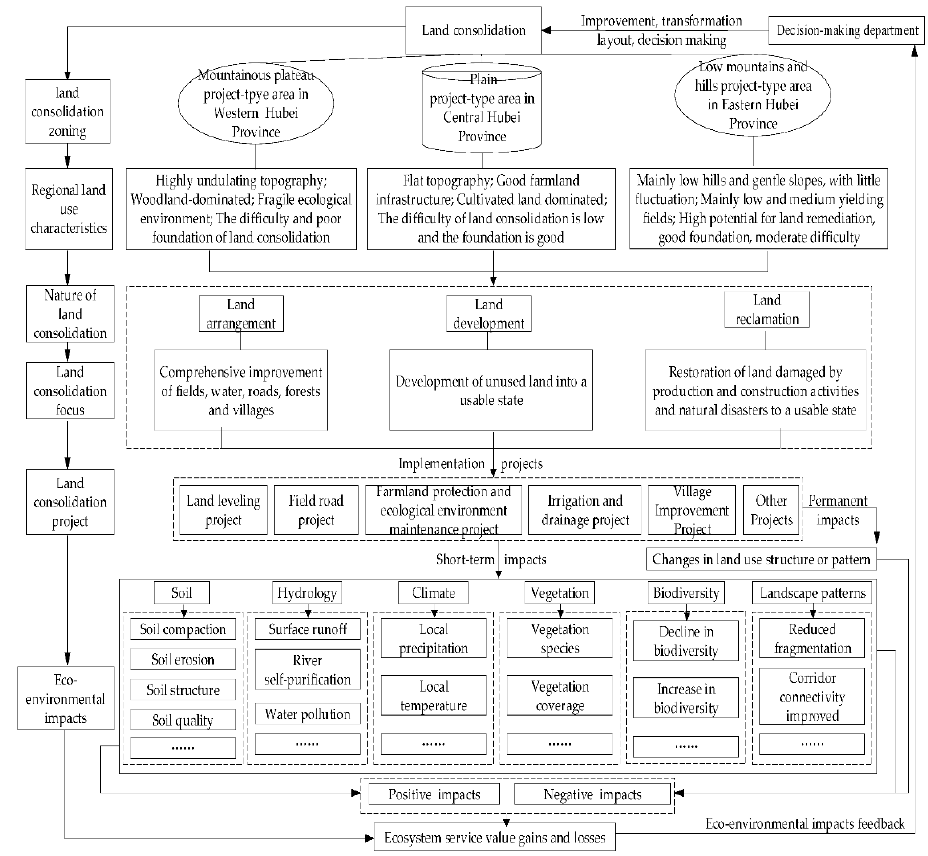
Figure 1. Mechanism of the impact of land consolidation projects on ESV gains and losses in Hubei